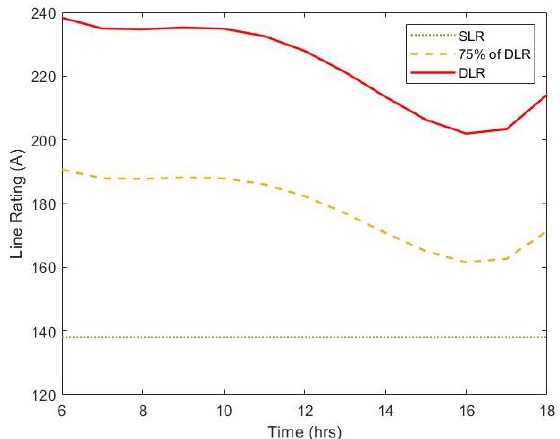
Figure 7. Line rating variation for 35 mm 2 ABC during the simulation